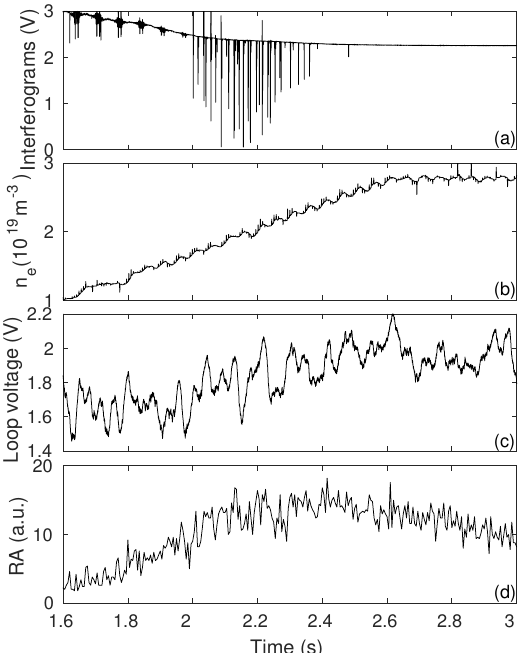
Figure 1: A typical example (EAST #72621) shows the existence of electron density threshold for the occurrence of the ω pe bursts: (a) interferograms measured by the Michelson interferometer, (b) line averaged electron den- sity along a vertical chord close to the plasma center, (c) plasma loop voltage, (d) γ ray counts.